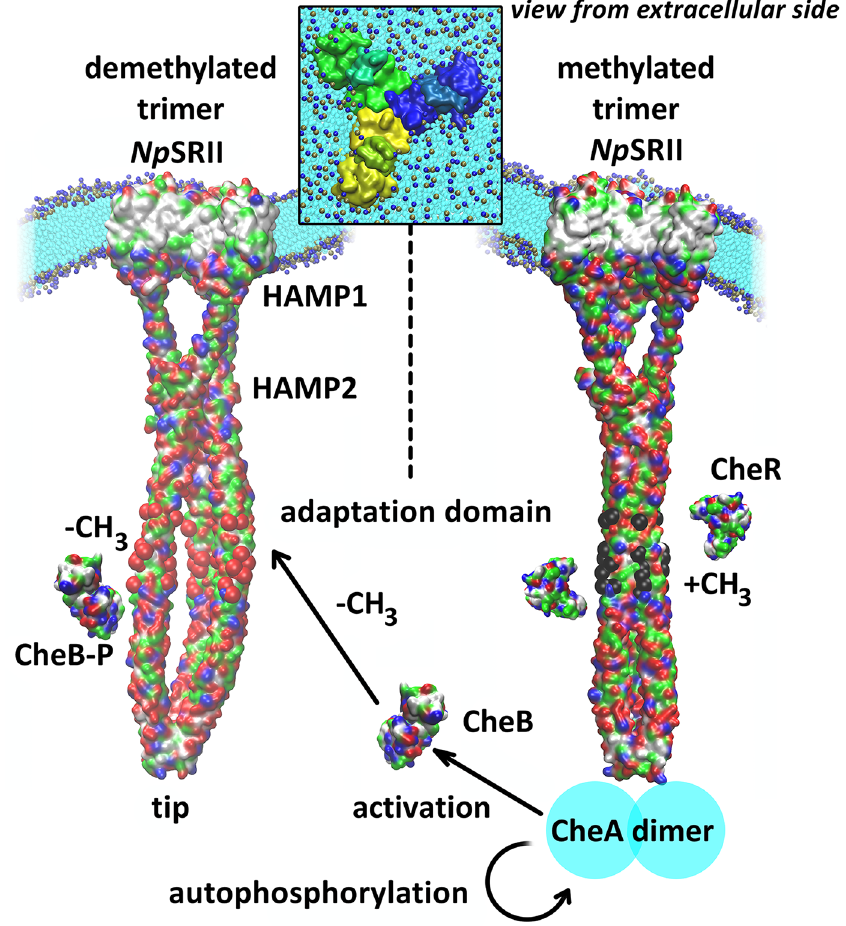
Fig 2. Conformations of the trimeric photoreceptor-transducer complexes. Cartoon with the resulting structures of the demethylated (left) and the methylated (right) trimer systems combined in the bent membrane with a schematic representation of the adaptation process. Methylation sites are shown as red and black spheres in the demethylated and methylated state, respectively.